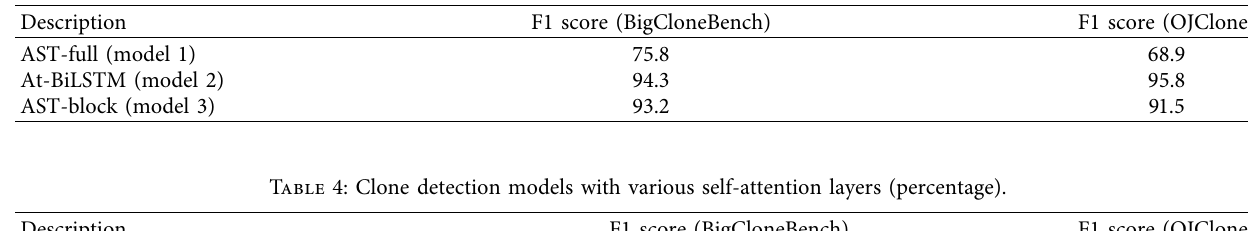
Table 3: Classification performance depending on AST splitting methods (percentage).